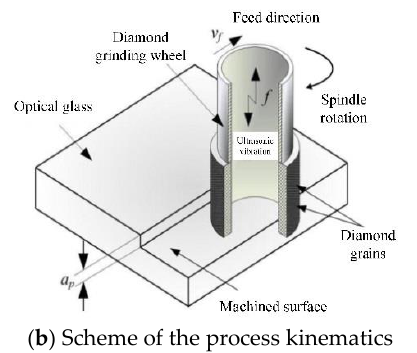
Figure 1. Experimental setup and scheme of the process kinematics. Table1. MachiningparametersinultrasonicvibrationassistedgrindingexperimentsofBK7opticalglass. Serial